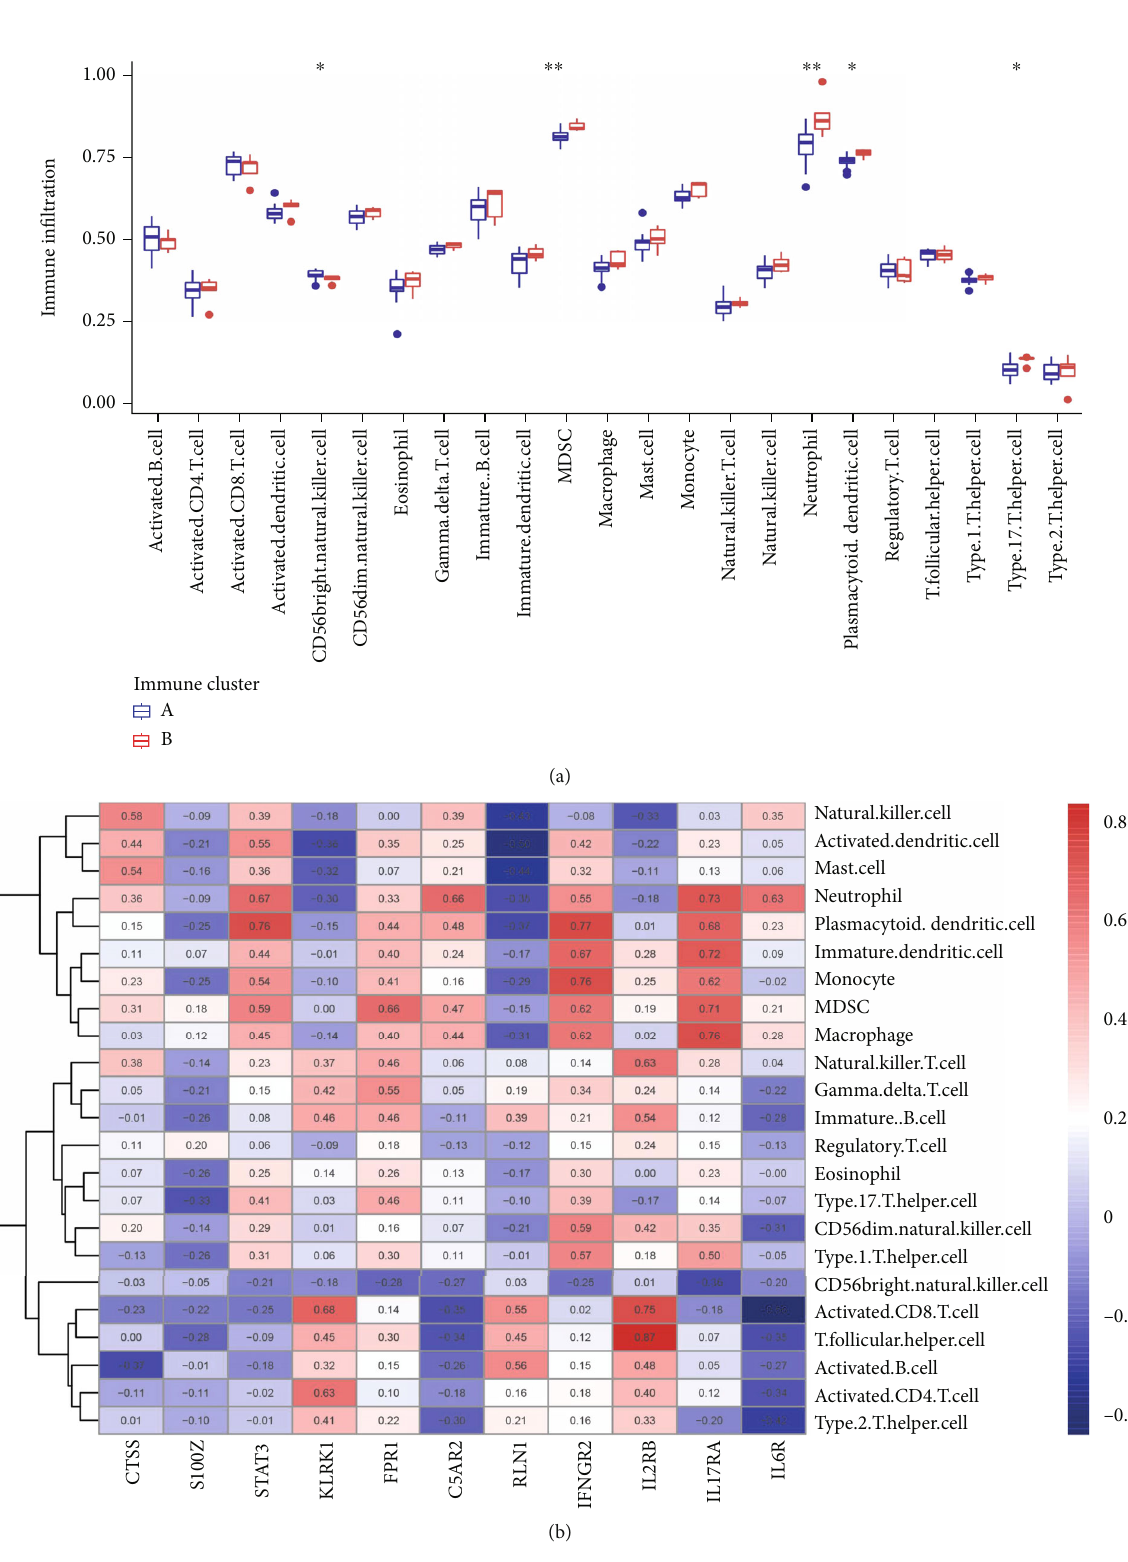
Figure 6: (a) Association between in fi ltrating immune cells and immune patterns. MDSC, neutrophil, plasmacytoid dendritic cell, and type 17 T helper cell were signi fi cantly highly expressed in immune cluster B, and CD56 bright natural killer cell was signi fi cantly highly expressed in immune cluster A. (b) The ssGSEA was used to compute the abundance of immune cells and to assess the association between 11 IRGs and immune